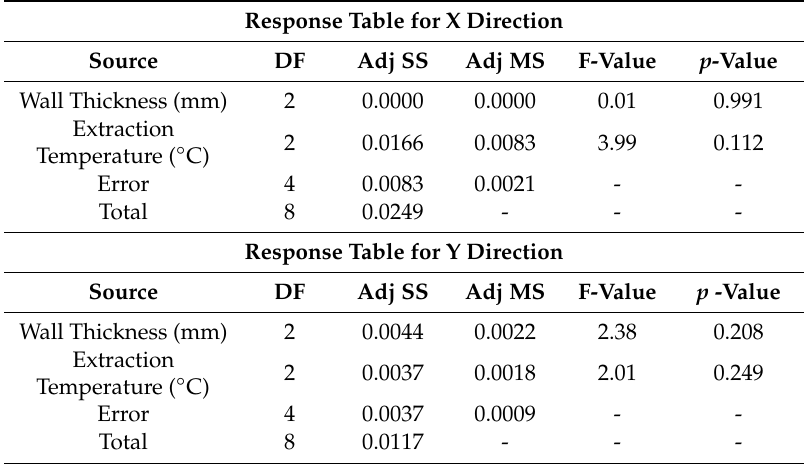
Table 8. ANOVA for dimensional deviation. Response Table for Χ Direction